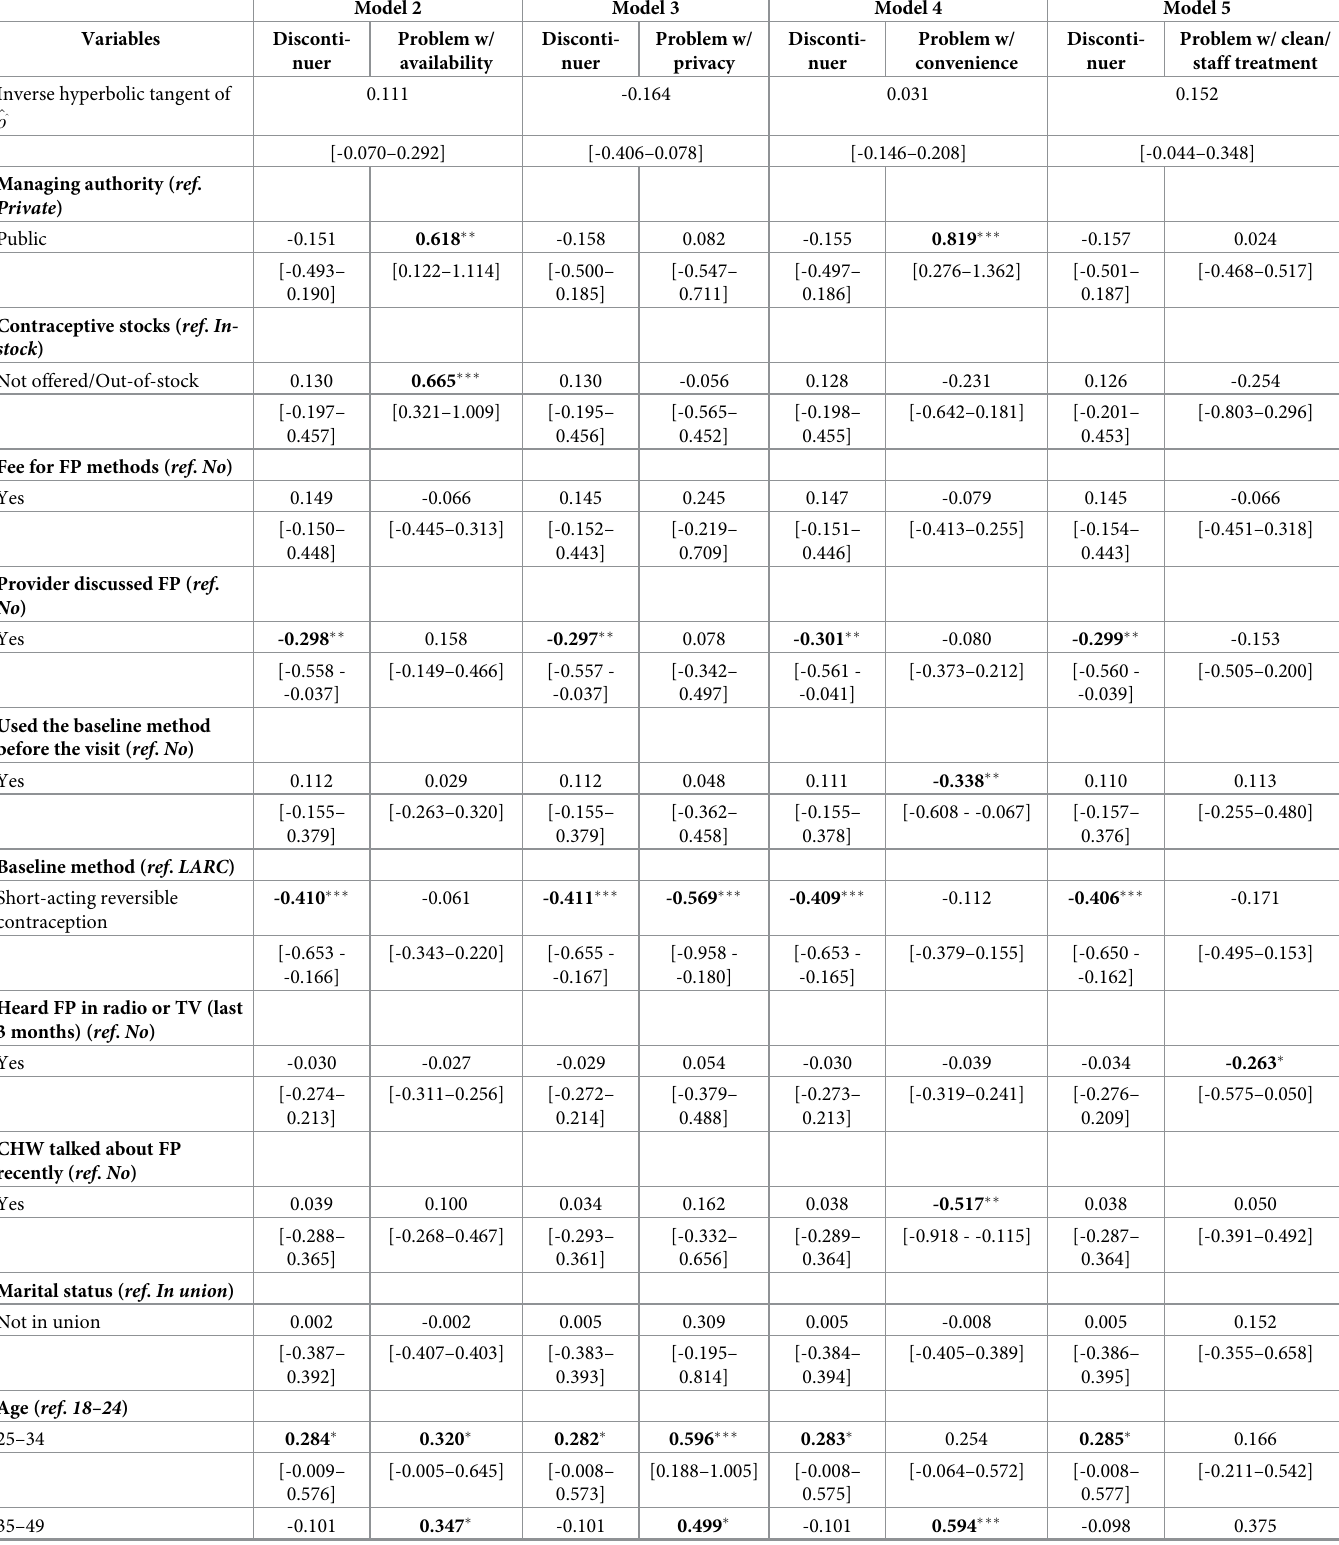
Table 4. Regression results from the seemingly unrelated bivariate probit